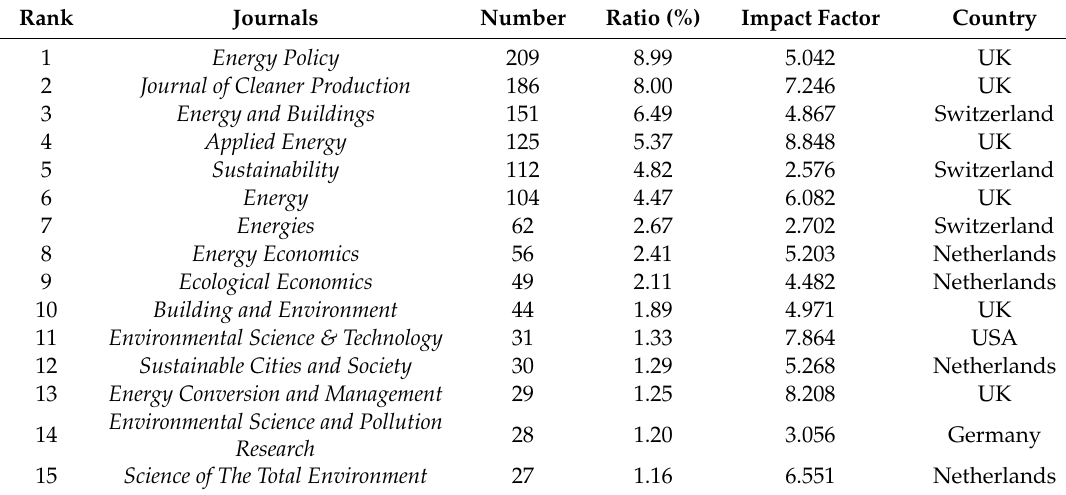
Table 1. The top 15 productive journals in HCE research.